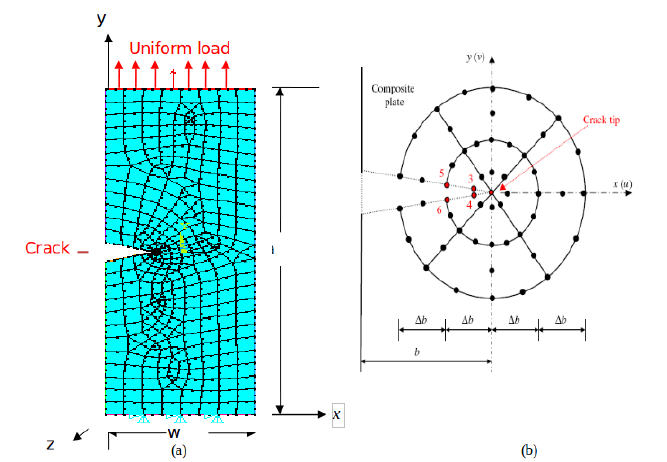
Figure 1: A finite element model of a laminated composite plate with (a) single edge V-notch and boundary conditions (b) crack tip sur- rounded by isoparametric quarter point elements (1 st ring) and regular elements (2 nd ring) [8].